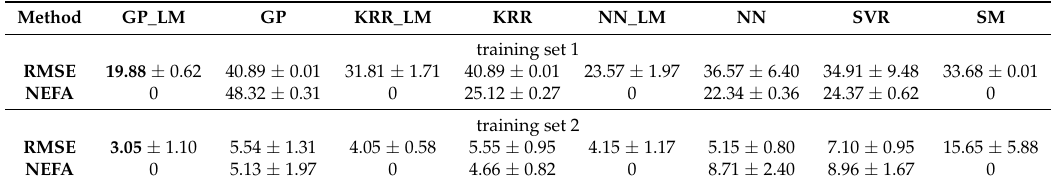
Table 2. Results on 20 runs of 10,000 test pixels generated by the Hapke model. The best performances are denoted in